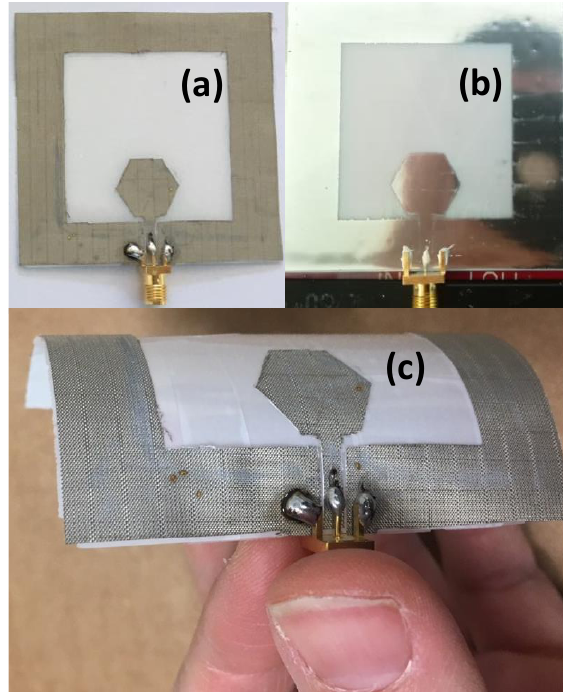
Figure 6. Manufactured prototypes of the antenna on ENrG’s Thin E-Strate using electrotextile flat ( a ); using silver conductive ink ( b ); and using electrotextile bent ( c ).